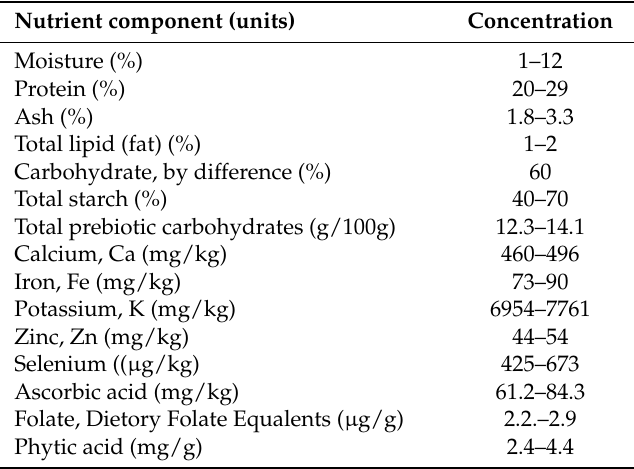
Table 1. Nutritional composition analysis of lentils grown in the USA and Canada